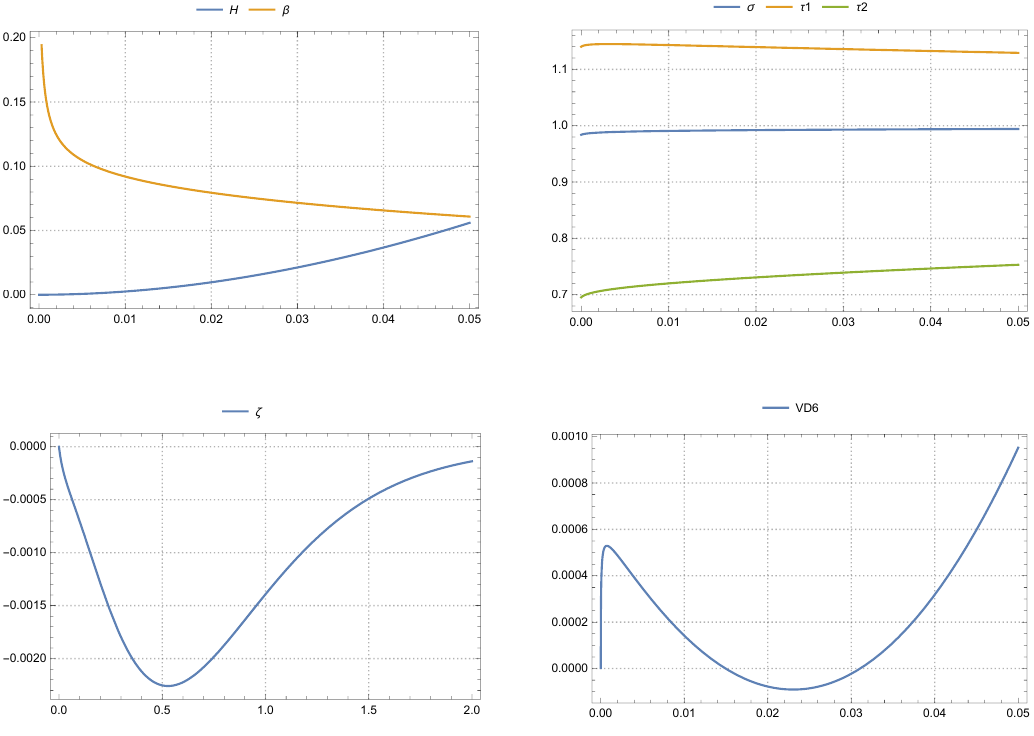
Figure 6 . Radial profile for the electric solution with parameters pξ 1 = pξ 3 = − 7 . 35 , pξ 2 = − 0 . 99 and r = 1 , with worldvolume flux f = 1 (notice the different scale of the horizontal axis for the H profile of the massive vector field). The temperature of this black hole is T = 0 . 000476